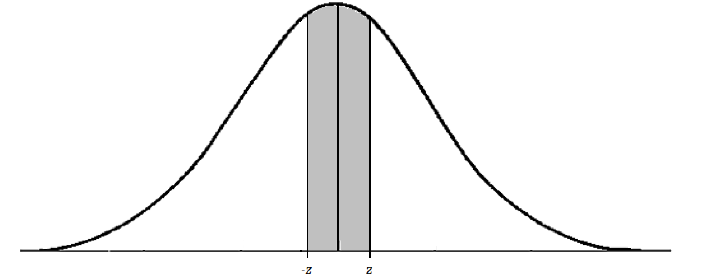
Figure 2. Normal distribution curve. The probability to minimize using (5) is